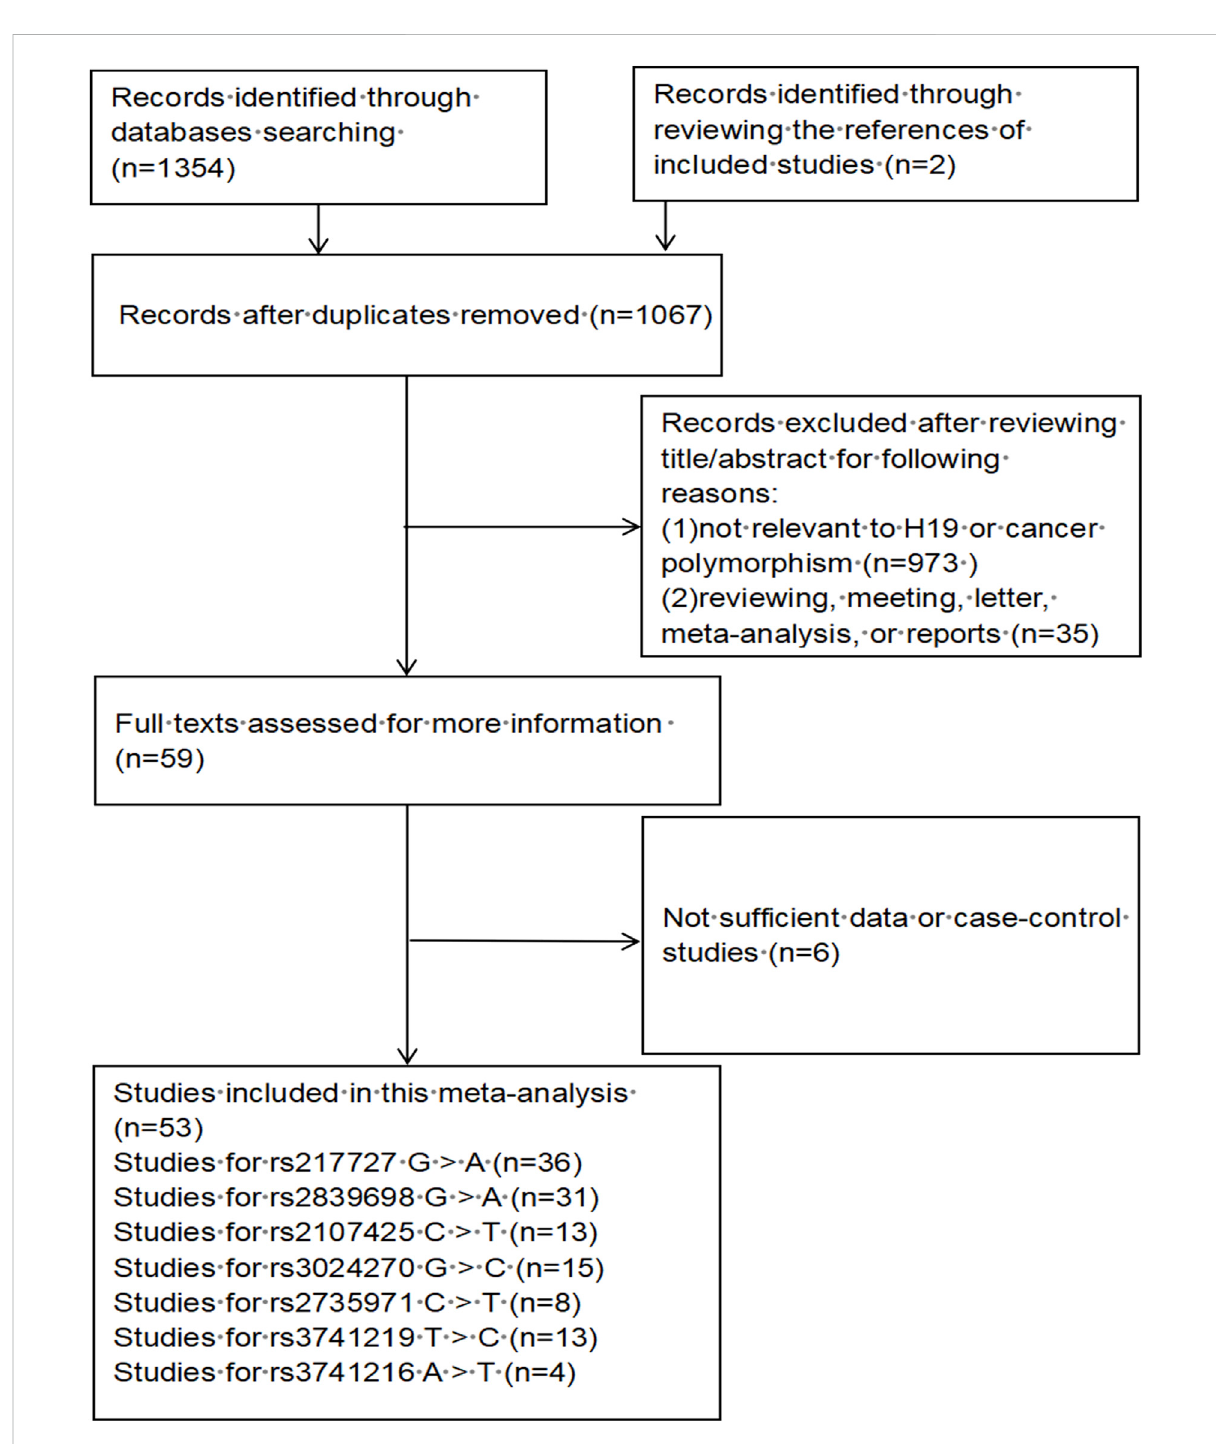
The fl ow diagram of this